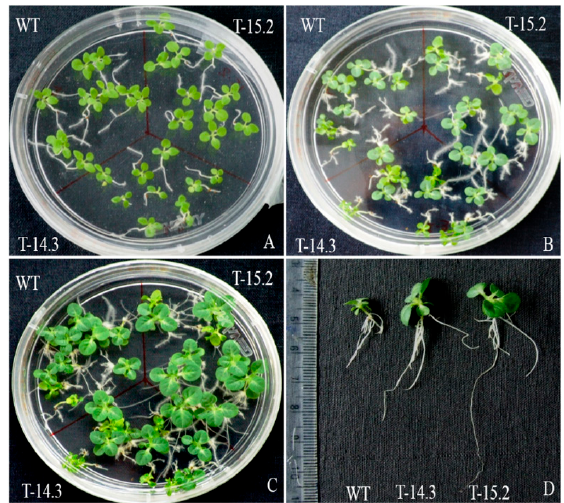
used to check the NaCl doses response (Figure 11D).